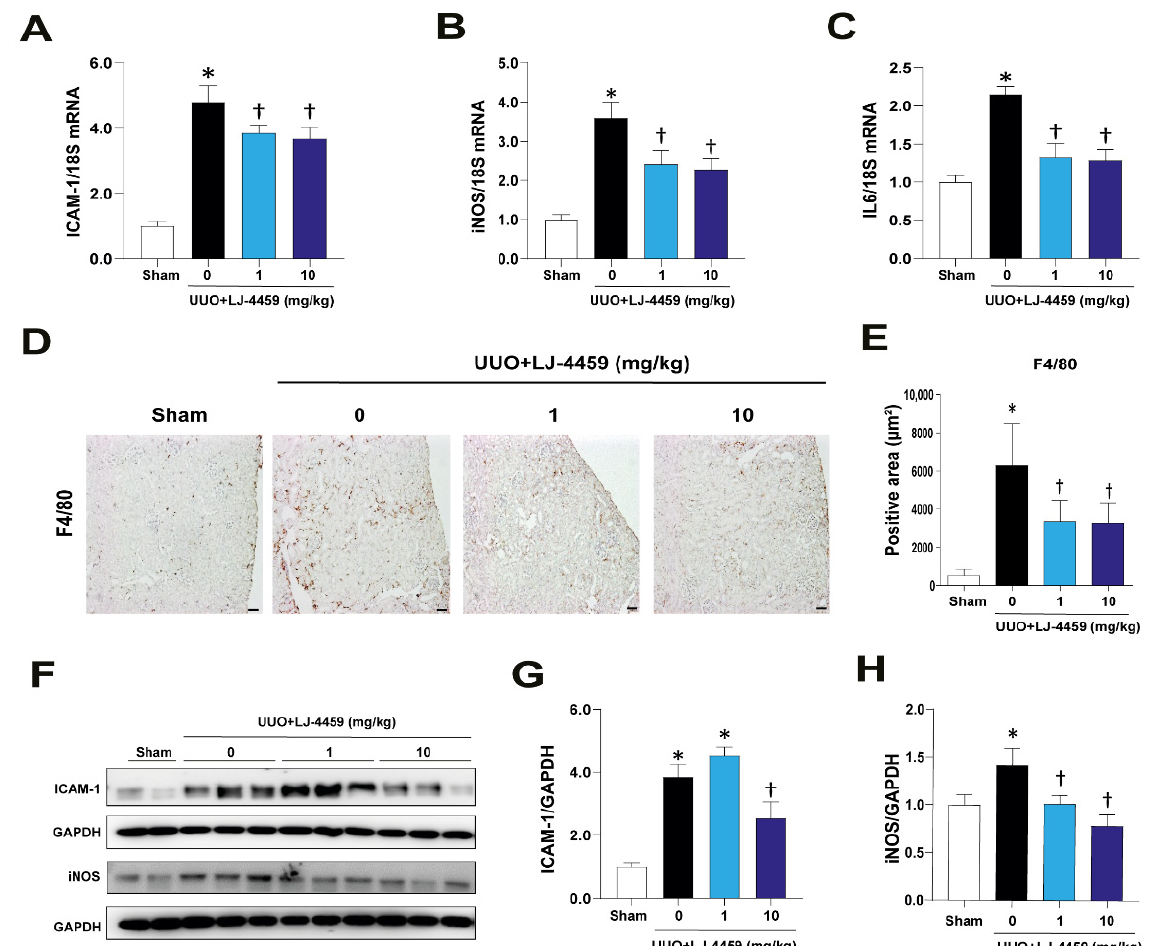
Figure 3. LJ-4459 ameliorates kidney inflammation in UUO mice. ( A – C ) The mRNA levels of inflammation markers such as ICAM-1, iNOS, and IL-6 were measured by real time RT-PCR. The levels of mRNA were normalized with 18S. ( D , E ) Paraffin-embedded kidney sections were stained with anti-F4/80 antibody (1:400; original magnification: 100 × ; scale bar: 50 µ m). Immunoblotting analysis of ( F – H ) ICAM-1 and iNOS in the kidney. The levels of proteins were normalized with GAPDH. Data are presented as mean ± SE of 7–8 mice. * p < 0.05 vs. sham mice, † p < 0.05 vs. UUO mice.